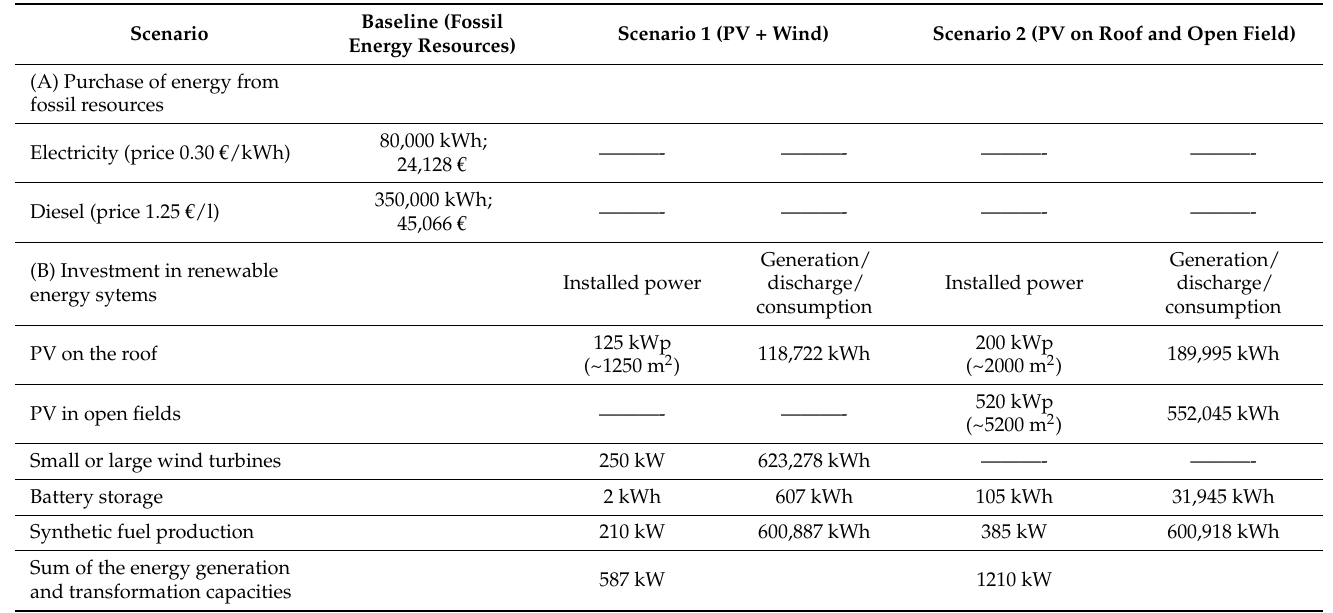
Table 3. Comparison of the technical parameters of the installed systems and their output (baseline, Scenario 1 and Scenario